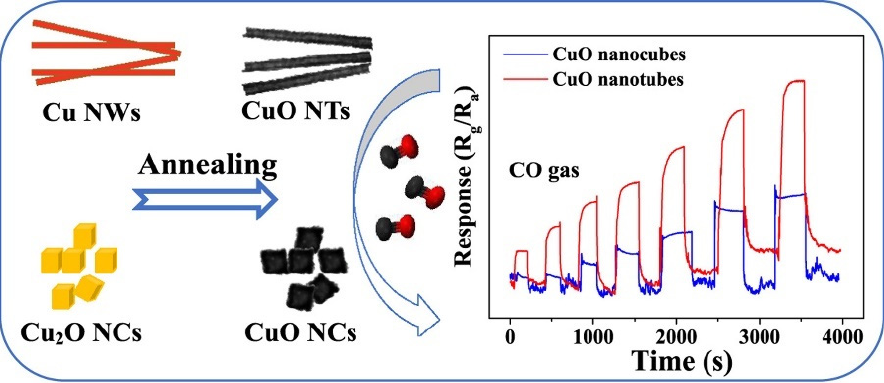
Figure 10. The preparation of CuO NTs and CuO NCs and CO gas-sensing behaviors of CuO NTs and CuO NCs at the operation temperature of 175 °C with different CO concentrations (50–1000 ppm). Reprinted with permission from Ref. [142]. Copyright 2018 Elsevier.